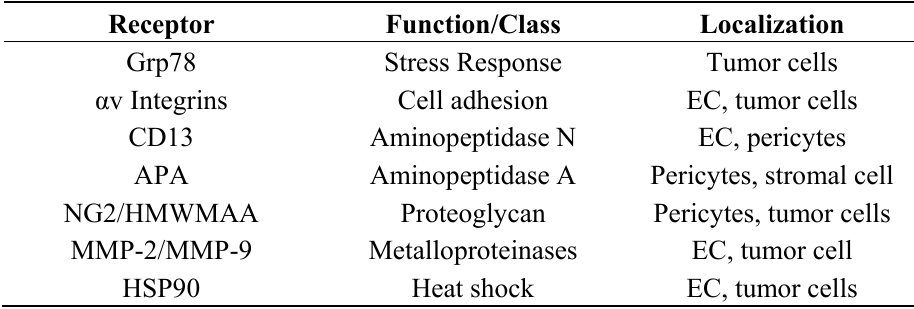
Table 2. List of receptors used in targeted cancer therapy